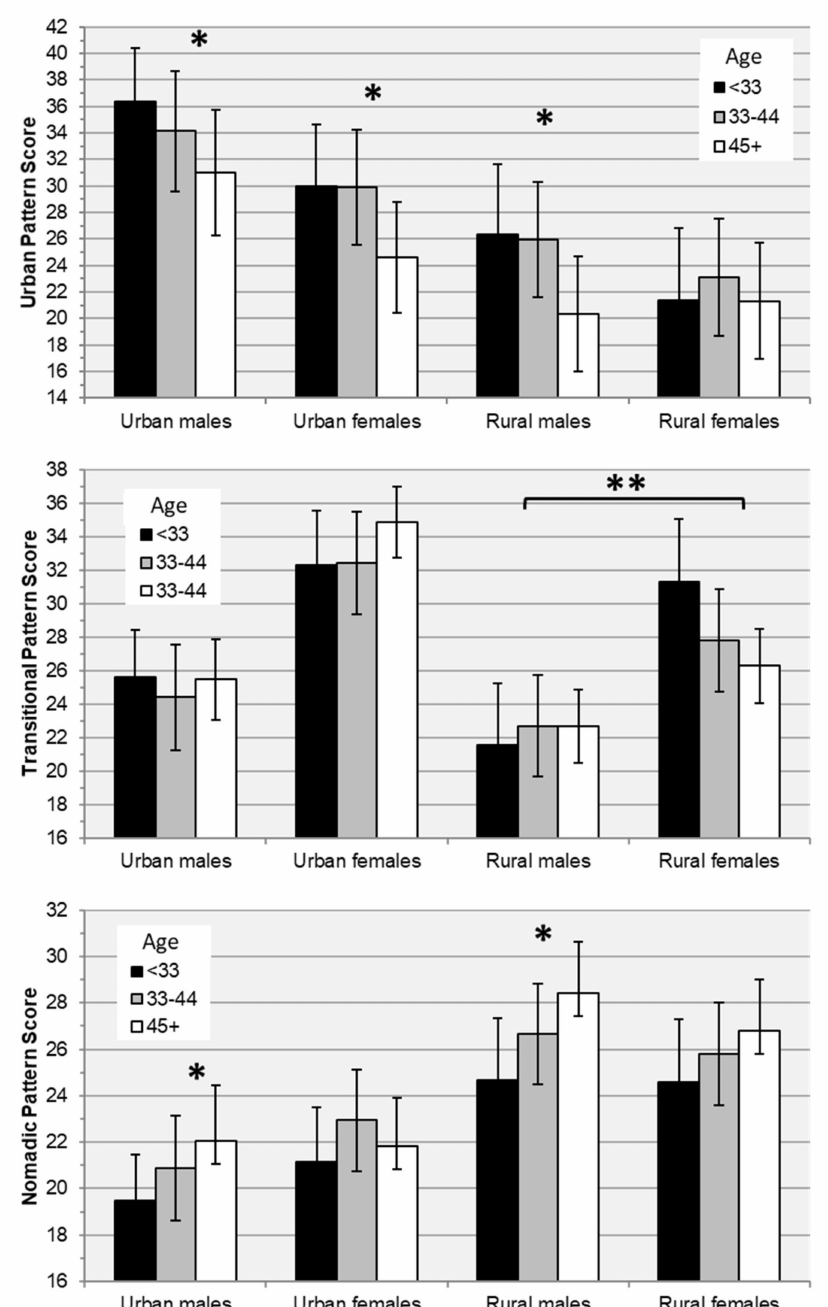
Figure 3. Age-trends in estimated marginal means of diet pattern scores by subgroup. Means are estimated using a regression model in which summer or winter pattern score ( n = 635) is predicted using an age group × urbanicity-sex group interaction term adjusted for province, season, within-season mean daily energy intake, and a random intercept per person to account for within-person correlation across seasons. Error bars indicate 95% confidence intervals. * Significant linear trend with age ( p < 0.05). ** Significant di ff erence in age trends between rural males and